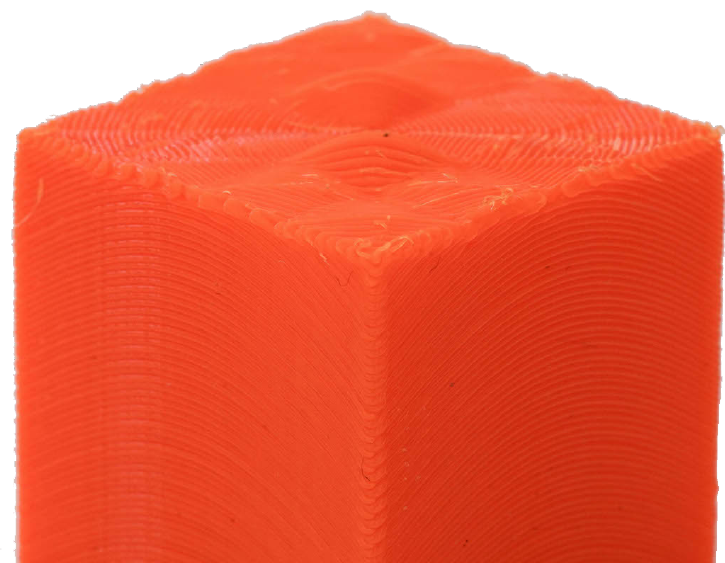
Figure 13. Top surface with artifacts, due to large triangles.